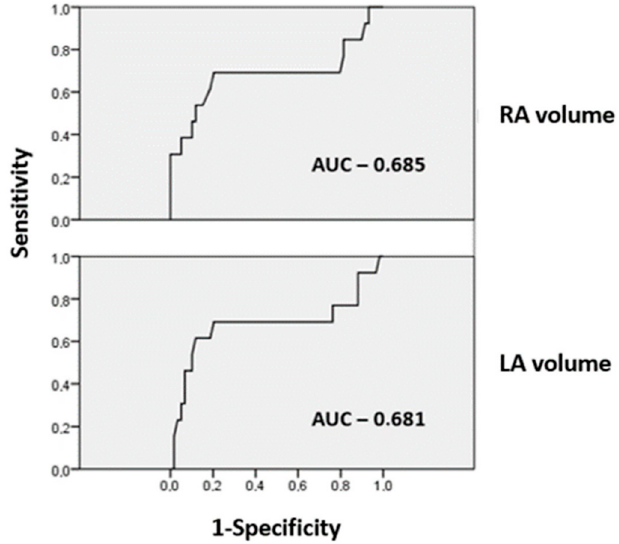
Figure 1. Receiver operating characteristic curve to assess the accuracy of RA and LA volumes in predicting HBE localization during the procedure. LA—left atrium; RA—right atrium; AUC—area under the curve.